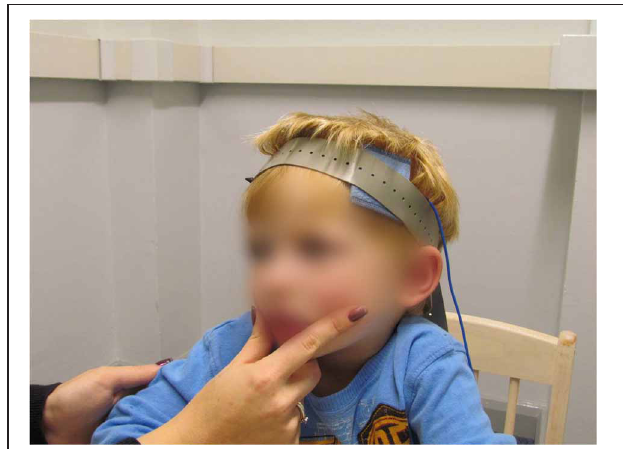
FIGURE 3 | Motor-based behavioral intervention and electromagnetic brain stimulation intervention. Child and therapist engaged in Prompts for Restructuring Oral Muscular Phonetic Targets (PROMPT) intervention. The child is also wearing a Transcranial Direct Current Stimulation (tDCS) electrode band. These two techniques are typically implemented separately. Here, the PROMPT therapist administers a physical prompt to the child’s vocal-motor system, in order to facilitate production of a speech target, while the tDCS electrode applies a direct current to the left inferior frontal